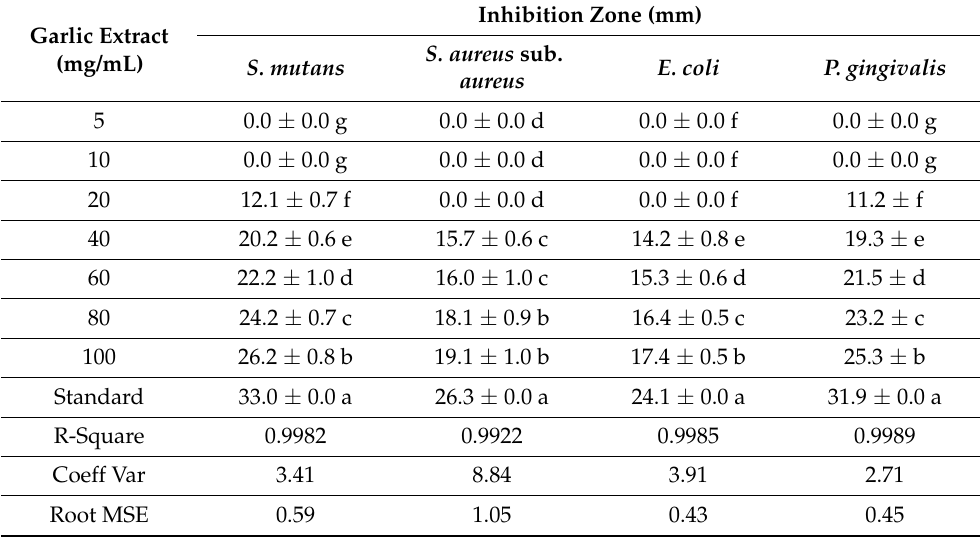
Values are the mean ± standard deviation (S.D.) of three replicates. According to Duncan’s multiple range test, S.D. within a column followed by different letters are significantly different at p ≤ 0.05 level. Coeff Var: oefficient of variation; Root MSE: Root-mean-square deviation.